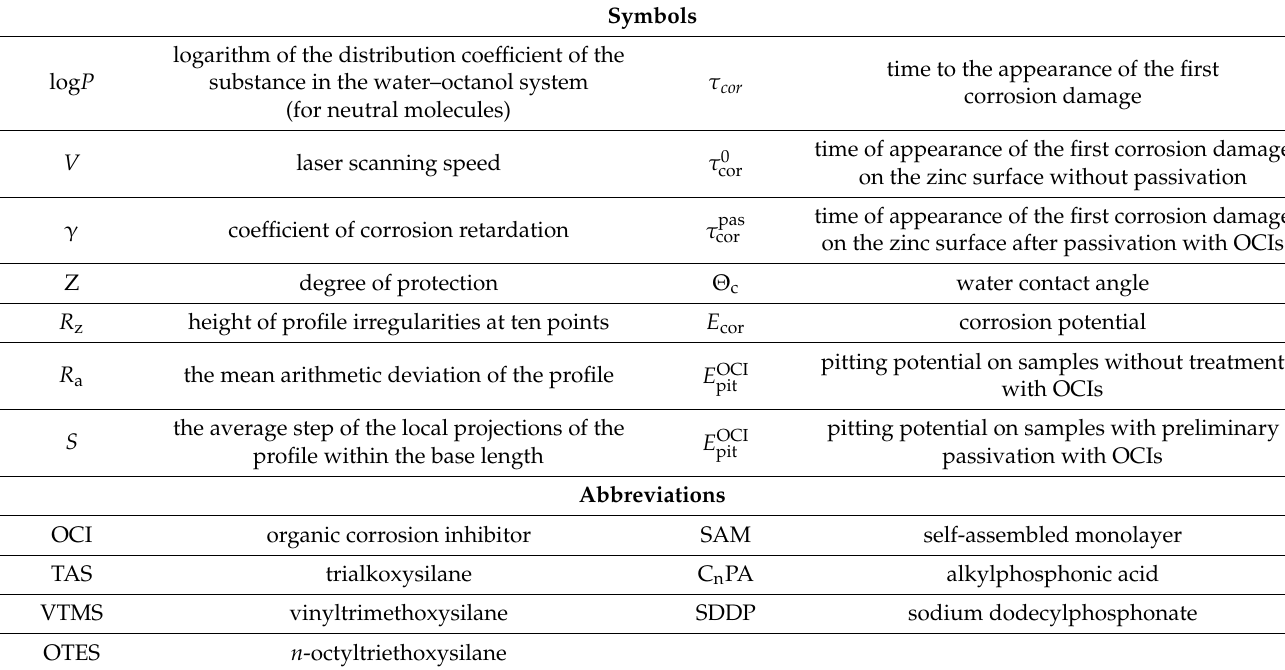
Table A1. List of most frequent abbreviations and